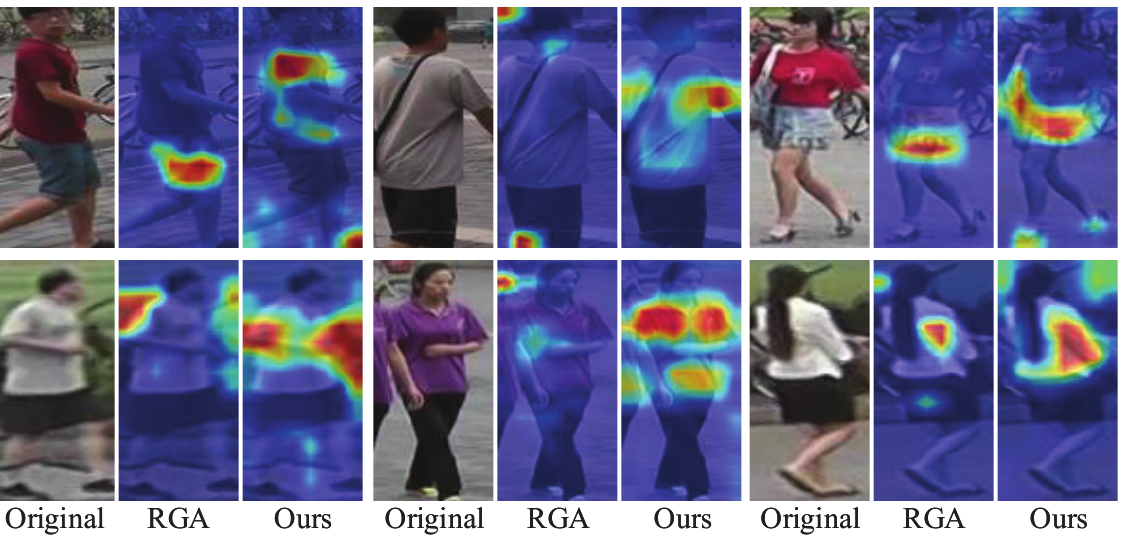
Figure 1. Examples of images that highlight important feature areas obtained from RGA and our method. For the color intensity, red indicates a large value while blue indicates a small one. Our work can capture wider and more accurate person identity information, compared with the RGA